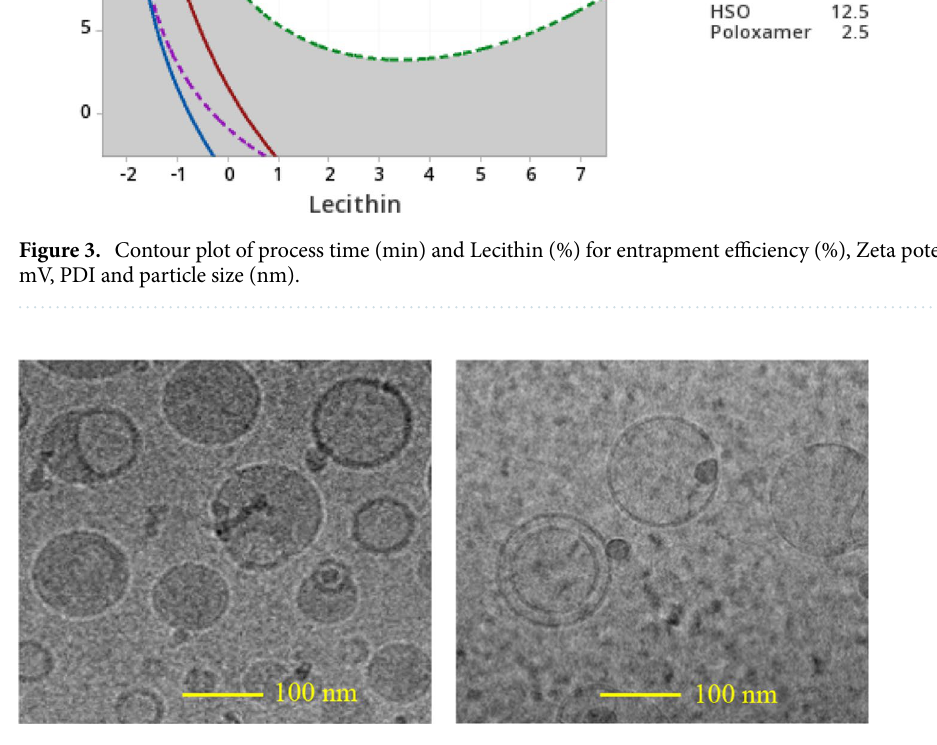
Figure 4. Cryo-electron microscopy of nanoemulsion formulation prepared by hempseed oil + lecithin + poloxamer 188 (30 mg/mL